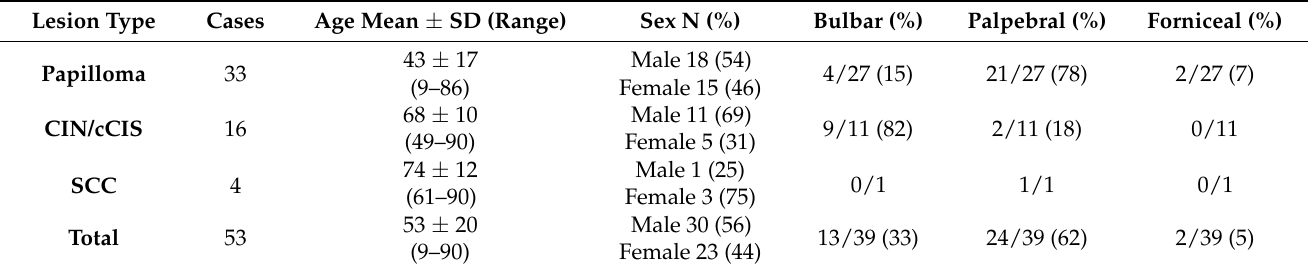
Table 1. Clinicopathologic Characteristics of Cases of Conjunctival Papillomas and OSSNs.